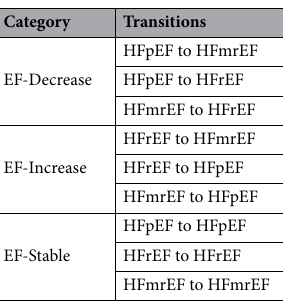
Table 1. HF patients defined based on categories of decreasing, increasing and stable EF measurements when studying longitudinal changes.